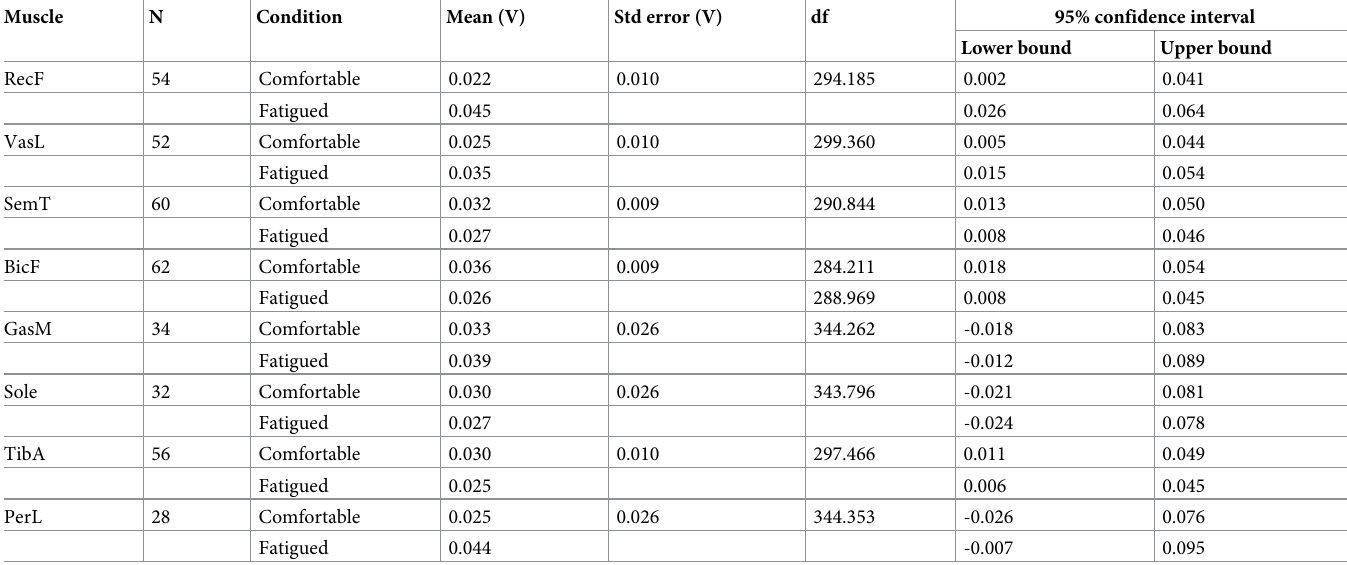
Table 4. Estimated marginal means of the RMS per muscle, based on the linear mixed-effects